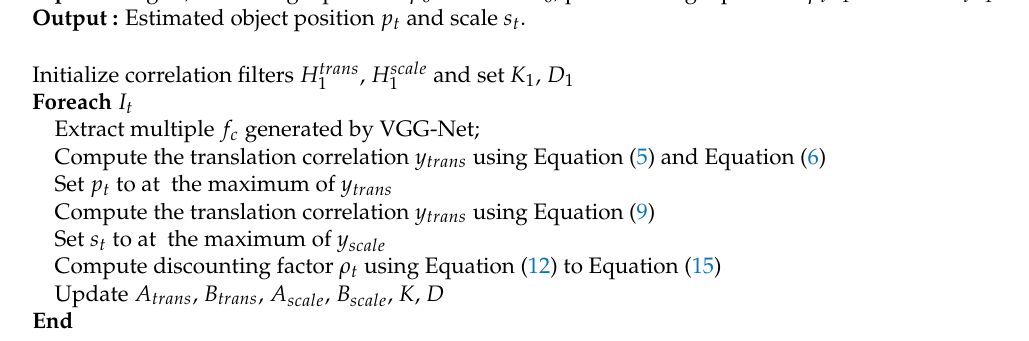
Algorithm 1: Proposed tracking algorithm.